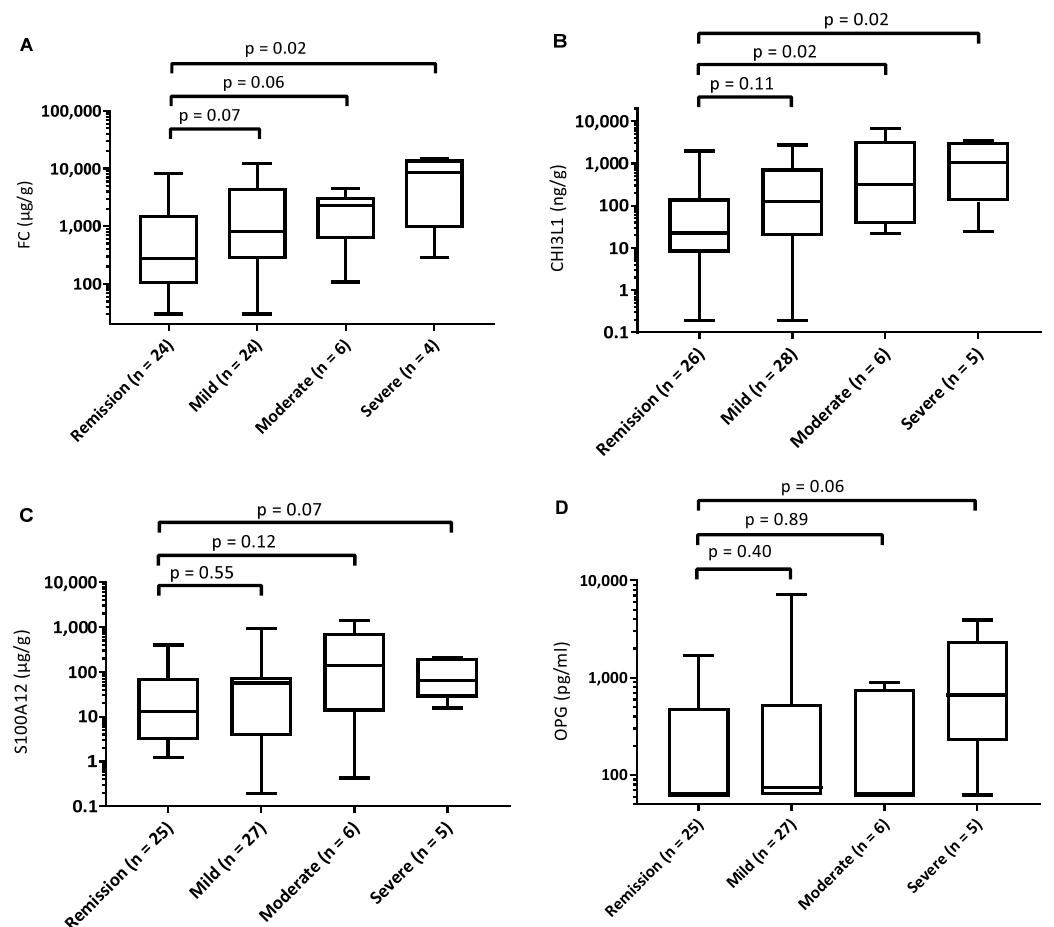
Figure 1. Boxplots showing biomarker levels for patients with Crohn’s disease according to clin- ical disease severity group. ( A ): fecal calprotectin, ( B ): fecal chitinase 3-like-1 protein, ( C ): fecal